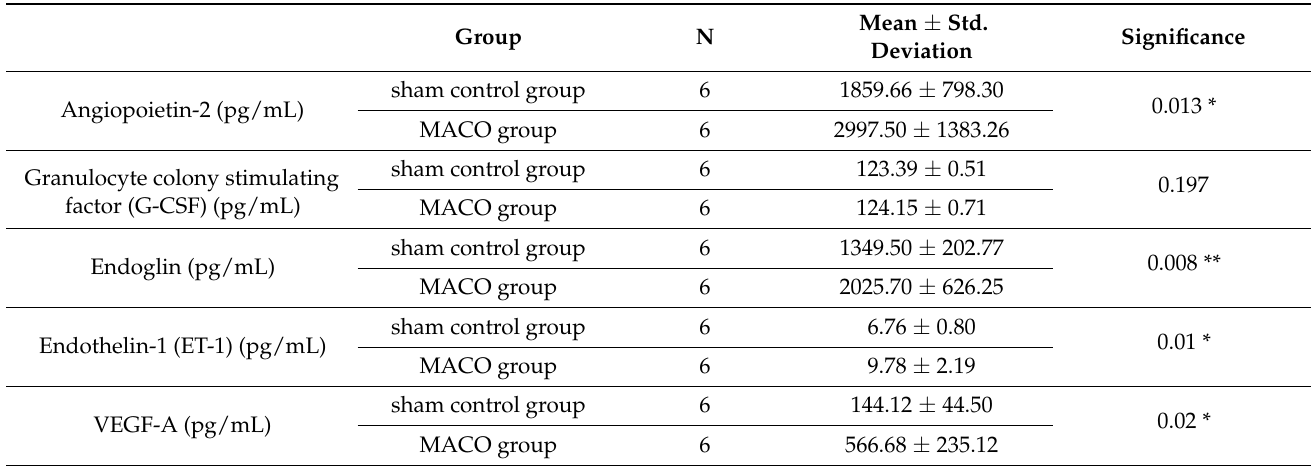
Table 1. Comparison of angiogenic factors between control rats and middle cerebral artery occlusion rats.